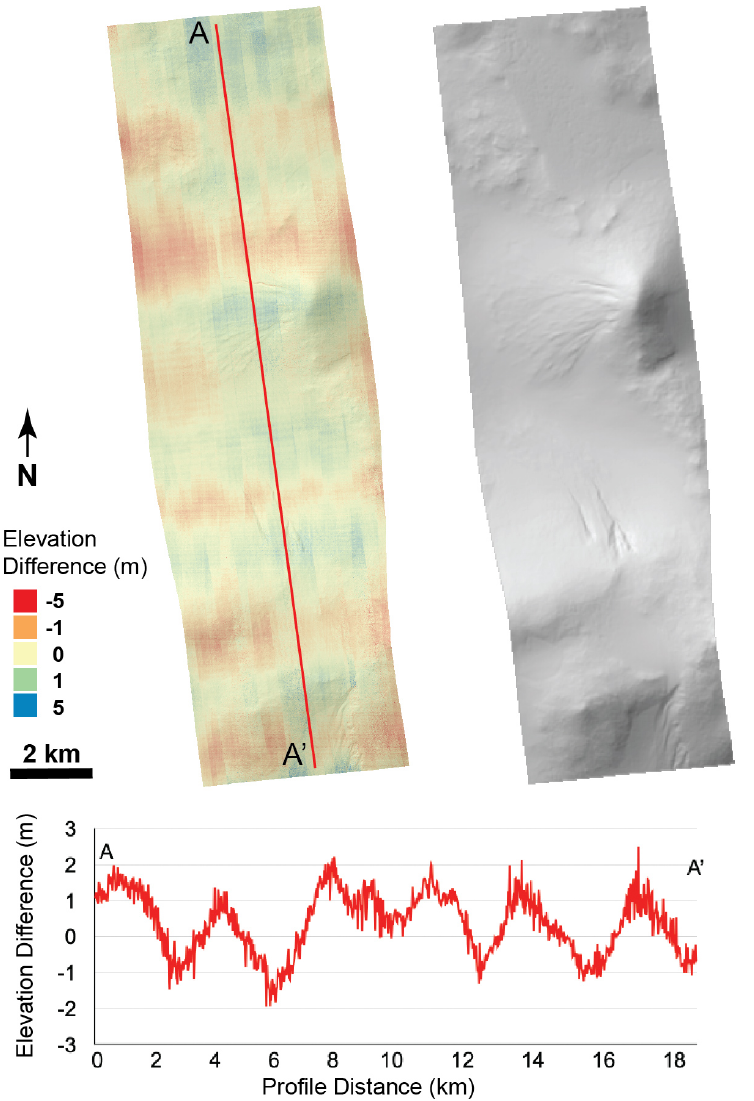
Figure 11. Lyot crater central peak (50.4 ◦ N, 29.3 ◦ E) difference of DTMs DTEEC_ 008823_2310_009245_2310_A01 and DTEEC_027376_2310_027297_2310_A01 displayed over the shaded relief map, illuminated from upper left. The difference map and profile show long-wavelength differences, ranging within ± 2 m amplitude, due to low-frequency jitter in one or both models. The shaded relief map is shown on the right without the difference map overlay, for